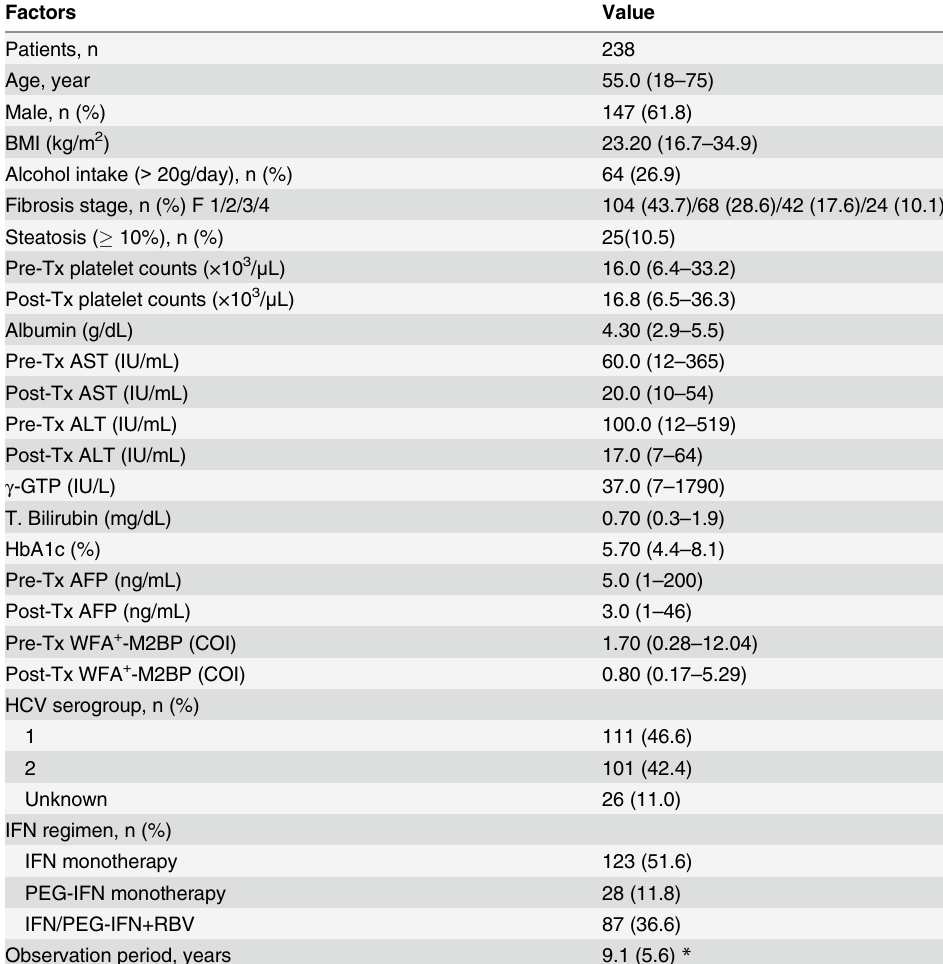
Table 1. Characteristics of Patients Enrolled in the Present Study. Factors Value Patients,